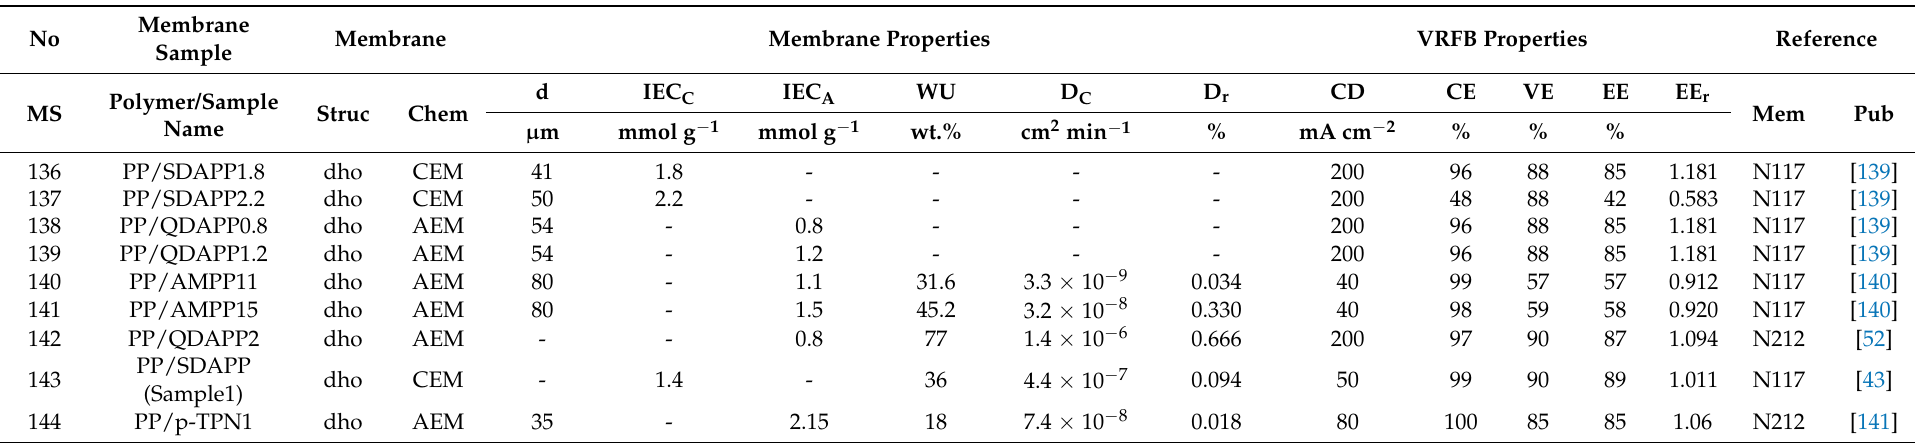
Table 6. List of poly(phenylene)-based hydro-carbon membrane samples.